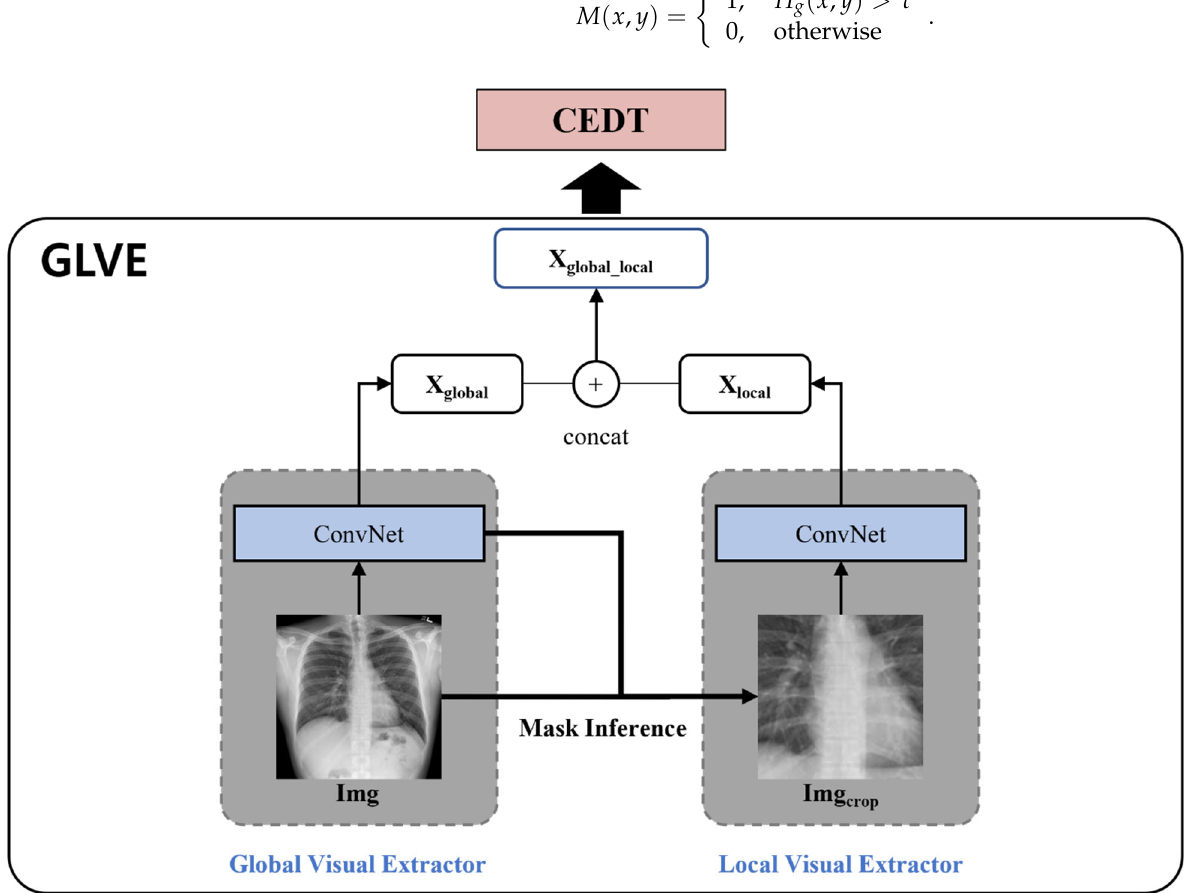
Figure 3. The pipeline of the GLVE. The GLVE consists of global visual extractor and local visual extractor. The global visual extractor uses a given image as an input and extracts global visual features. After extracting them, the attention guided mask inference process is performed to crop the image for the local visual extractor.